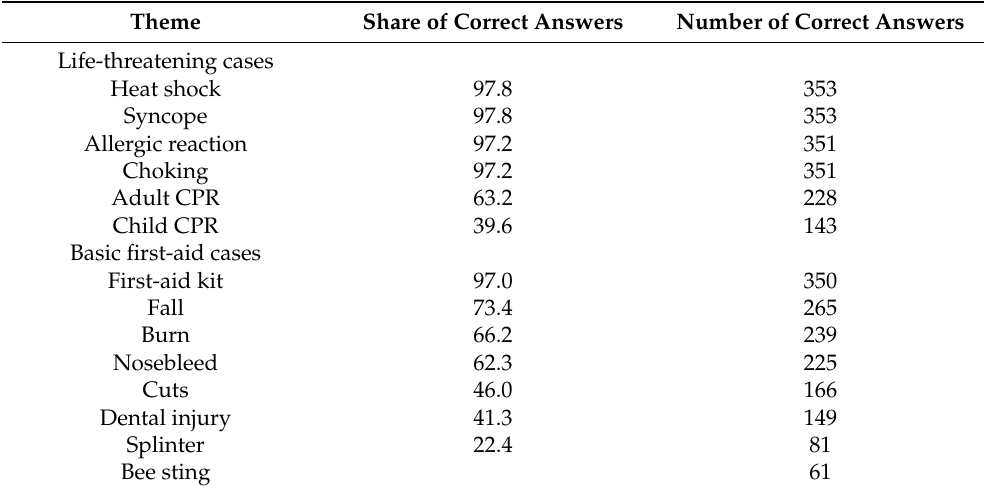
Table 2. Overview of the number and share of correct responses to each case.